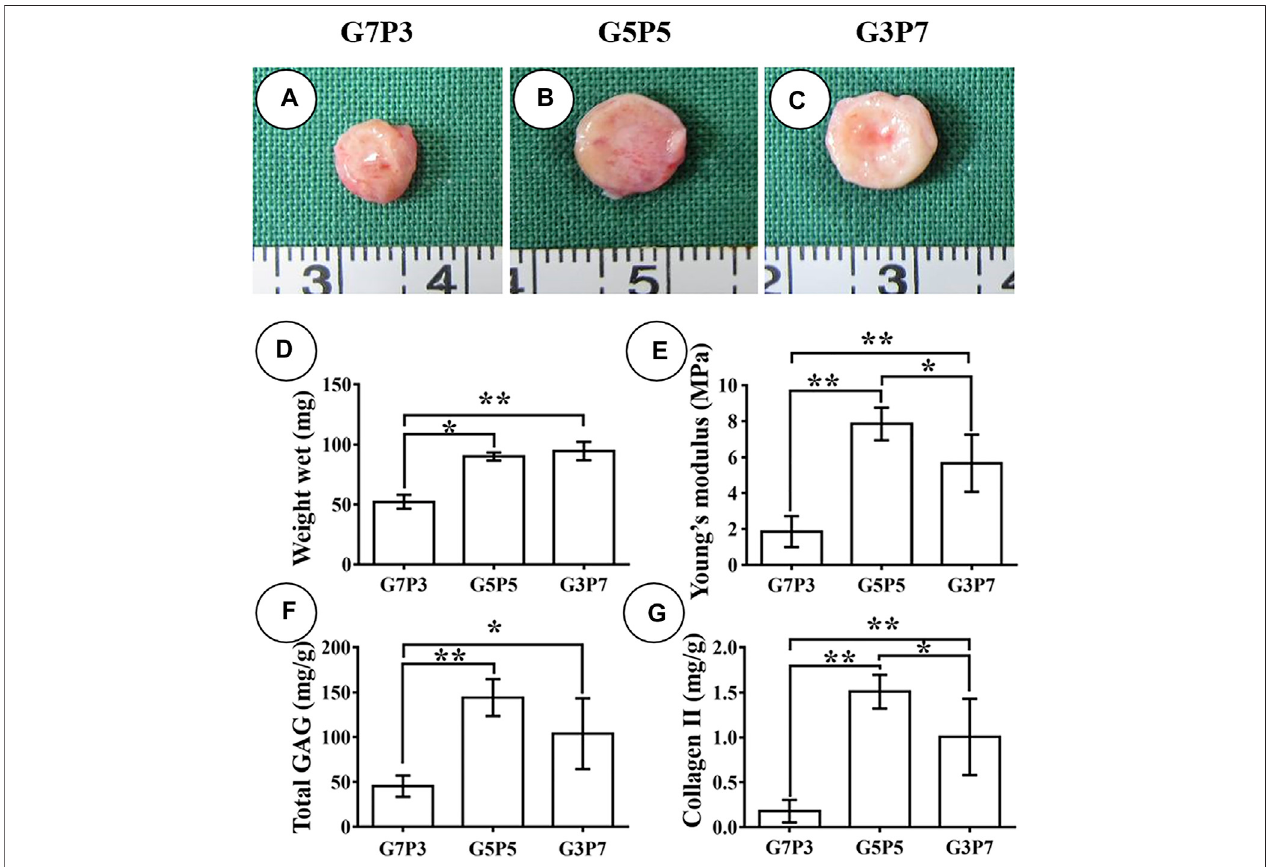
FIGURE5| Gross viewand quantitativeanalysisofengineered tissues at 6 weeks invivo .The samples intheG7P3group remarkably shrink (A) while thesamples intheG5P5andG3P7groupsretaintheoriginalsize (B,C) .QuantitativeanalysisrevealsthatthesamplesintheG7P3groupshowlowervaluesinwetweight,totalGAG, Collagen Ⅱ , and Young ’ s modulus (D – G) than those in the G5P5 and G3P7 groups. The samples in the G5P5 group show higher Young ’ s modulus and collagen II content compared to those in the G3P7 group (E,G) . *Indicating signi fi cant differences (* p < 0.05; ** p < 0.01).